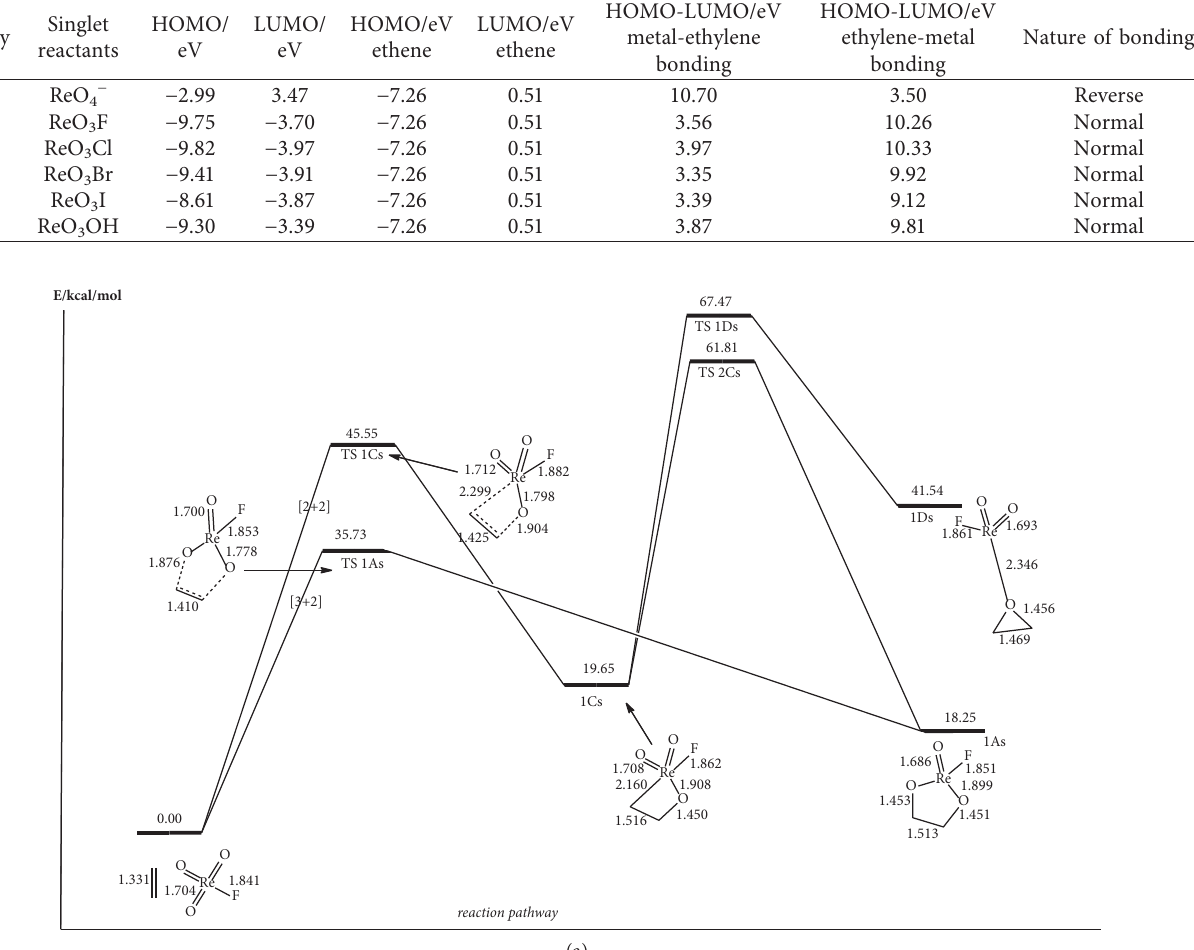
Table 2: The Frontier Molecular Orbitals calculation for the rhenium oxo